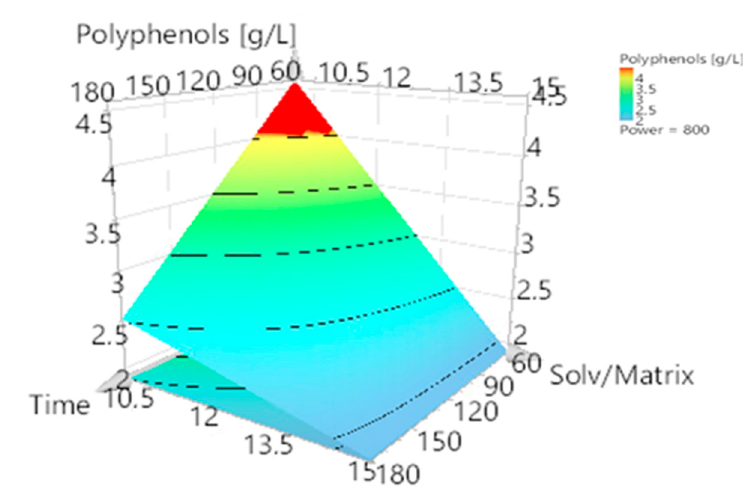
Figure 2. Contour plot. Power set was used to estimate the change in polyphenols as a function of time and solvent/matrix ratio. From left to right, the power was set to 500, 650 and 800 W. The red zone represents the conditions for obtaining the highest concentration of polyphenols.